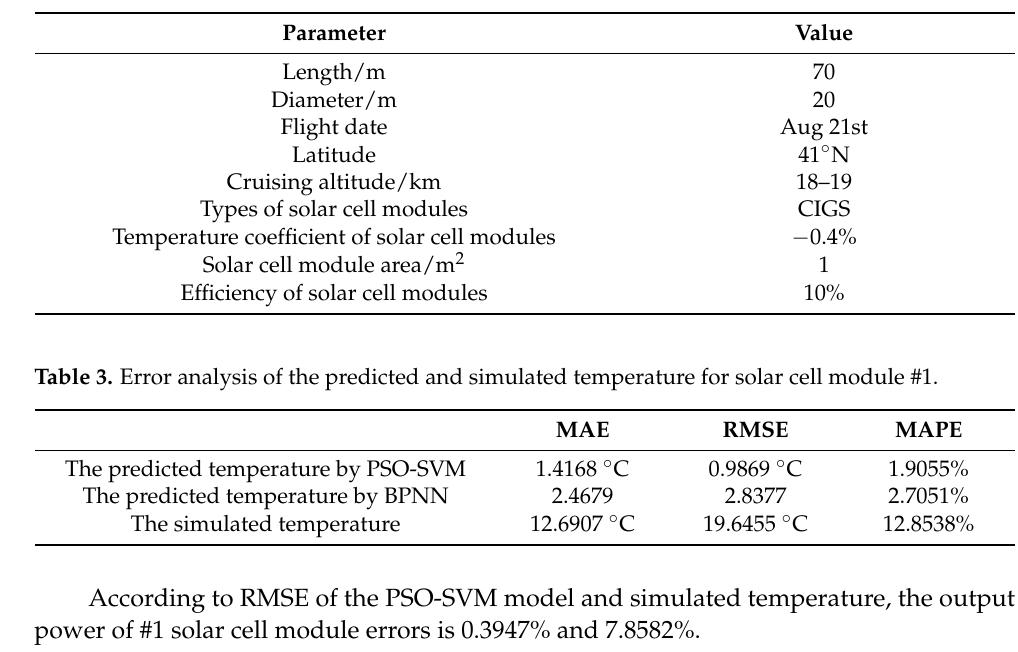
Figure 8. Measured data of two solar cell module’s operating temperature during flight test. Table 2. Table of simulation parameters.